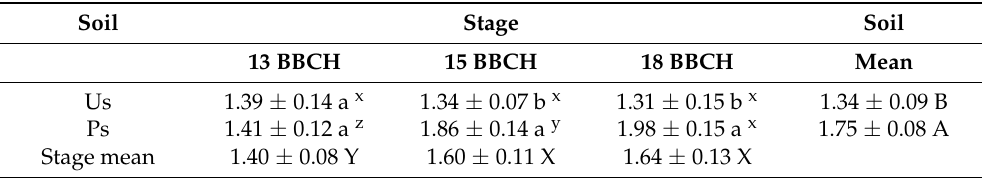
Table 10. Free proline content in different development stages of S. perfoliatum plants grown in Ps and